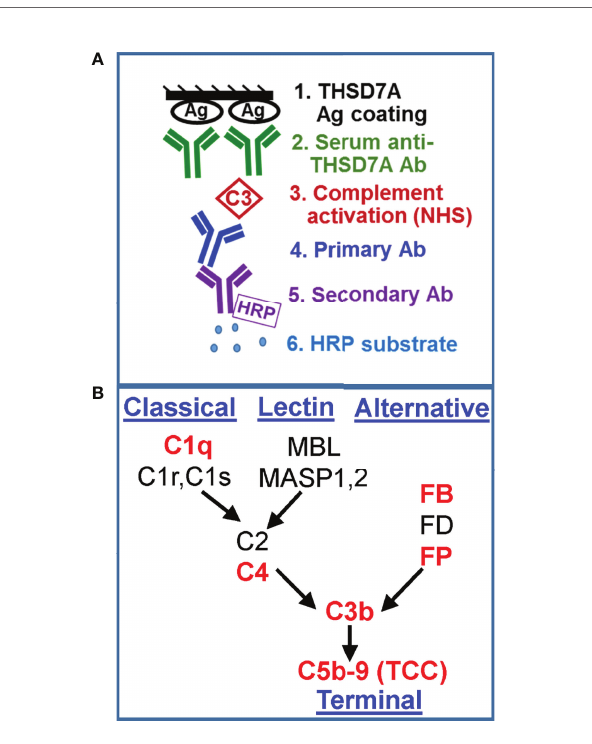
FIGURE 3 | Development of a functional assay for complement fi xation by THSD7A ICs. (A) Schematic representation of the in vitro assay for complement activation. (B) Simpli fi ed diagram of the complement activation pathways. The complement proteins for which the binding to ICs was assayed in this study are shown in